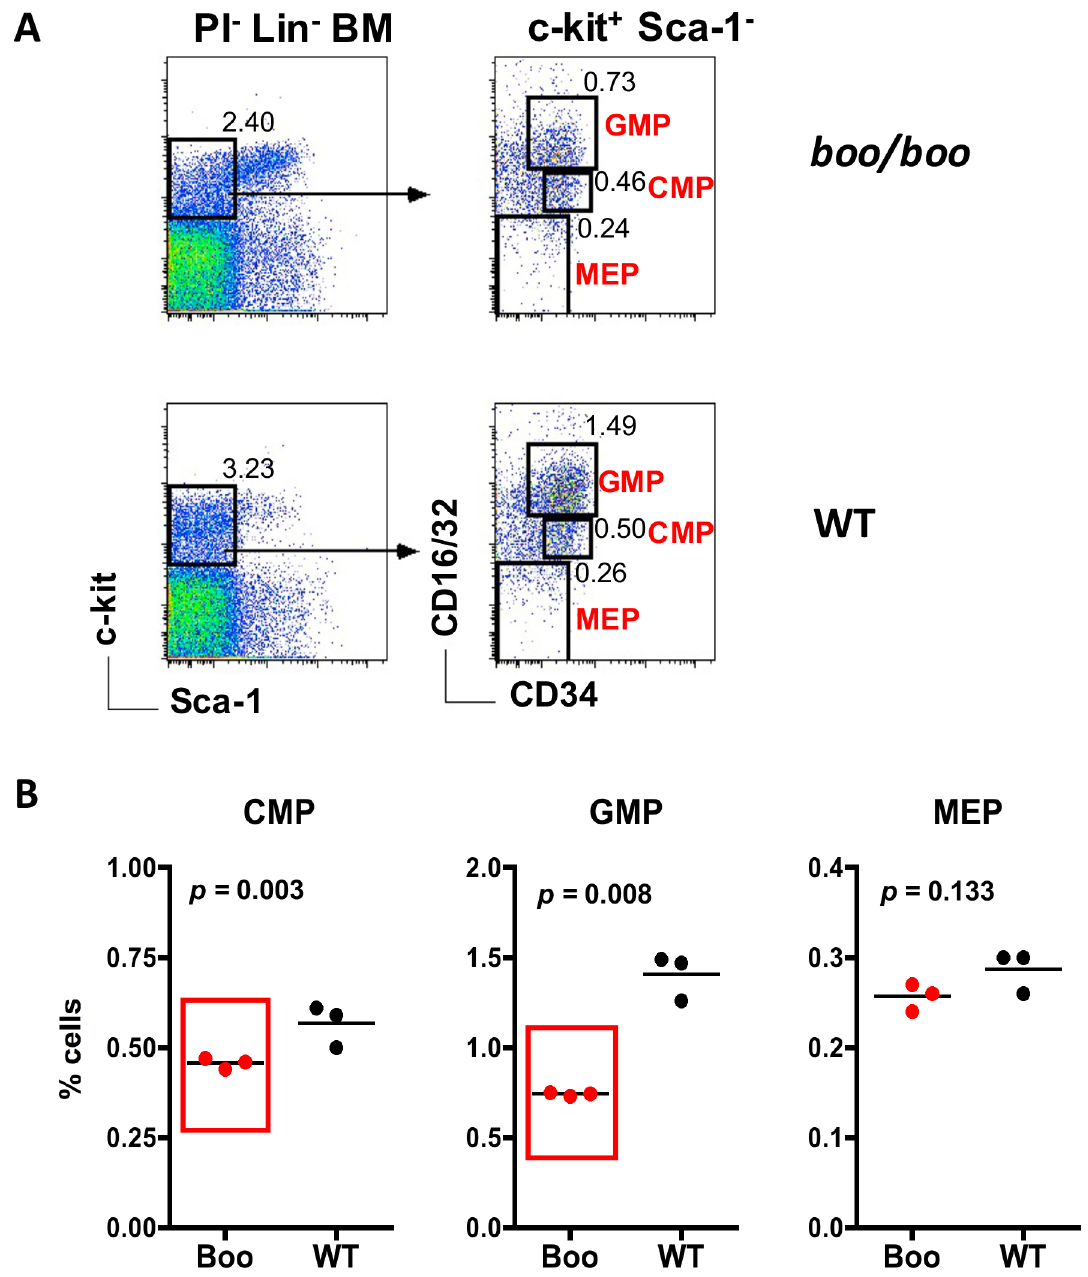
Fig 5. Booreana ( boo/boo ) mice show a reduction in myeloid progenitors in bone marrow. Cells from boo/boo and WT mice were preparedand stained with antibodiesto distinguishhematopoietic progenitors flow cytometrically. A lineage cocktail of antibodieswas used to gate the Lin - subsets, so excludingmature cells. Sca-1 and c-kit stainingwas used to identify the Lin - c-kit + Sca-1 + subset. Stainingfor CD34 and CD16/32was used to distinguishCMPs, GMPs, and MEPs. Propidiumiodide(PI; 1 μ g/ml) staining was used to gate live cells (PI - ). Gates were set on bivariateplots using isotype control antibodies, and numbers in gates reflect % positive cells amongst Lin - PI - bone marrow cells. (A) Profiles for representative individualmice are shown. (B) Percent cells amongst viableLin - bone marrow is shown for 3 individual mice, with mean value shown as a bar, and statistically significantresults (p (cid:20) 0.05) boxed in red.